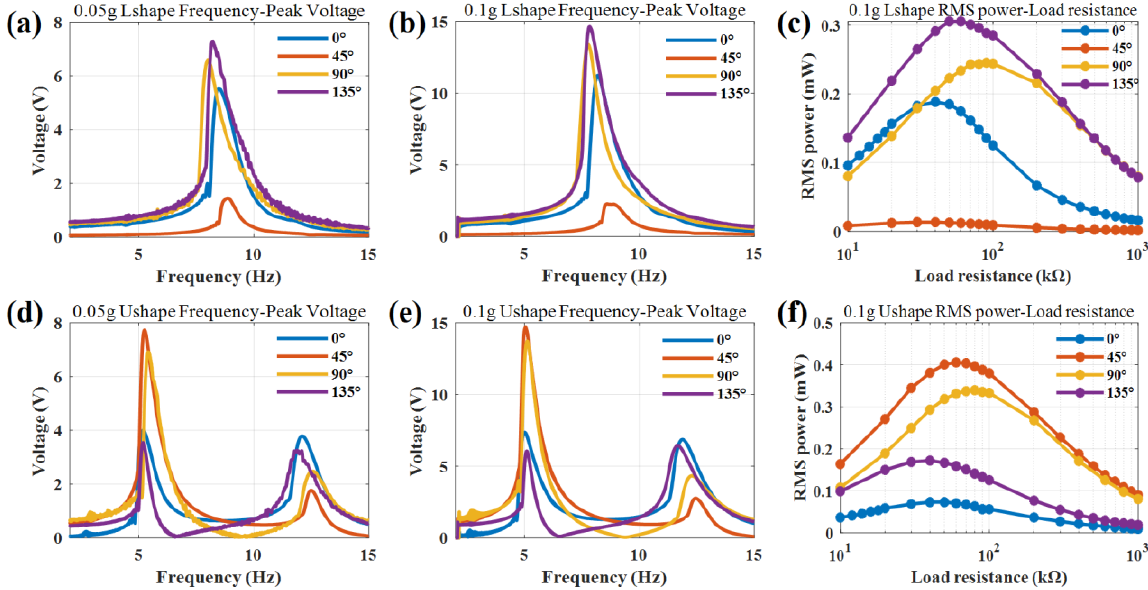
Figure 7. Experimental voltage frequency response curves with different clamping angles: the L-shaped PVEH at an acceleration of ( a ) 0.05 g and ( b ) 0.1 g; the U-shaped PVEH at an acceleration of ( d ) 0.05 g and ( e ) 0.1 g. Experimental curves of RMS power with load resistance with different clamping angle at an acceleration of 0.1 g: ( c ) the L-shaped PVEH at 7.9 Hz; ( f ) the U-shaped PVEH at 5.0 Hz.